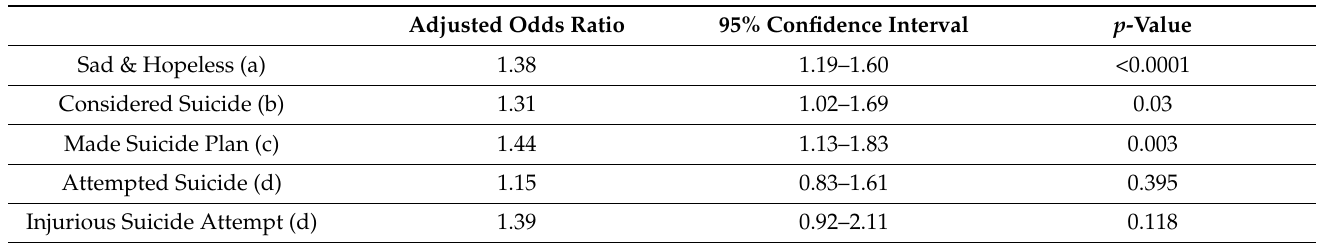
Table 2. Multivariable logistic regression analysis for the association between hallucinogen use, and hopelessness and suicidality among American adolescents.